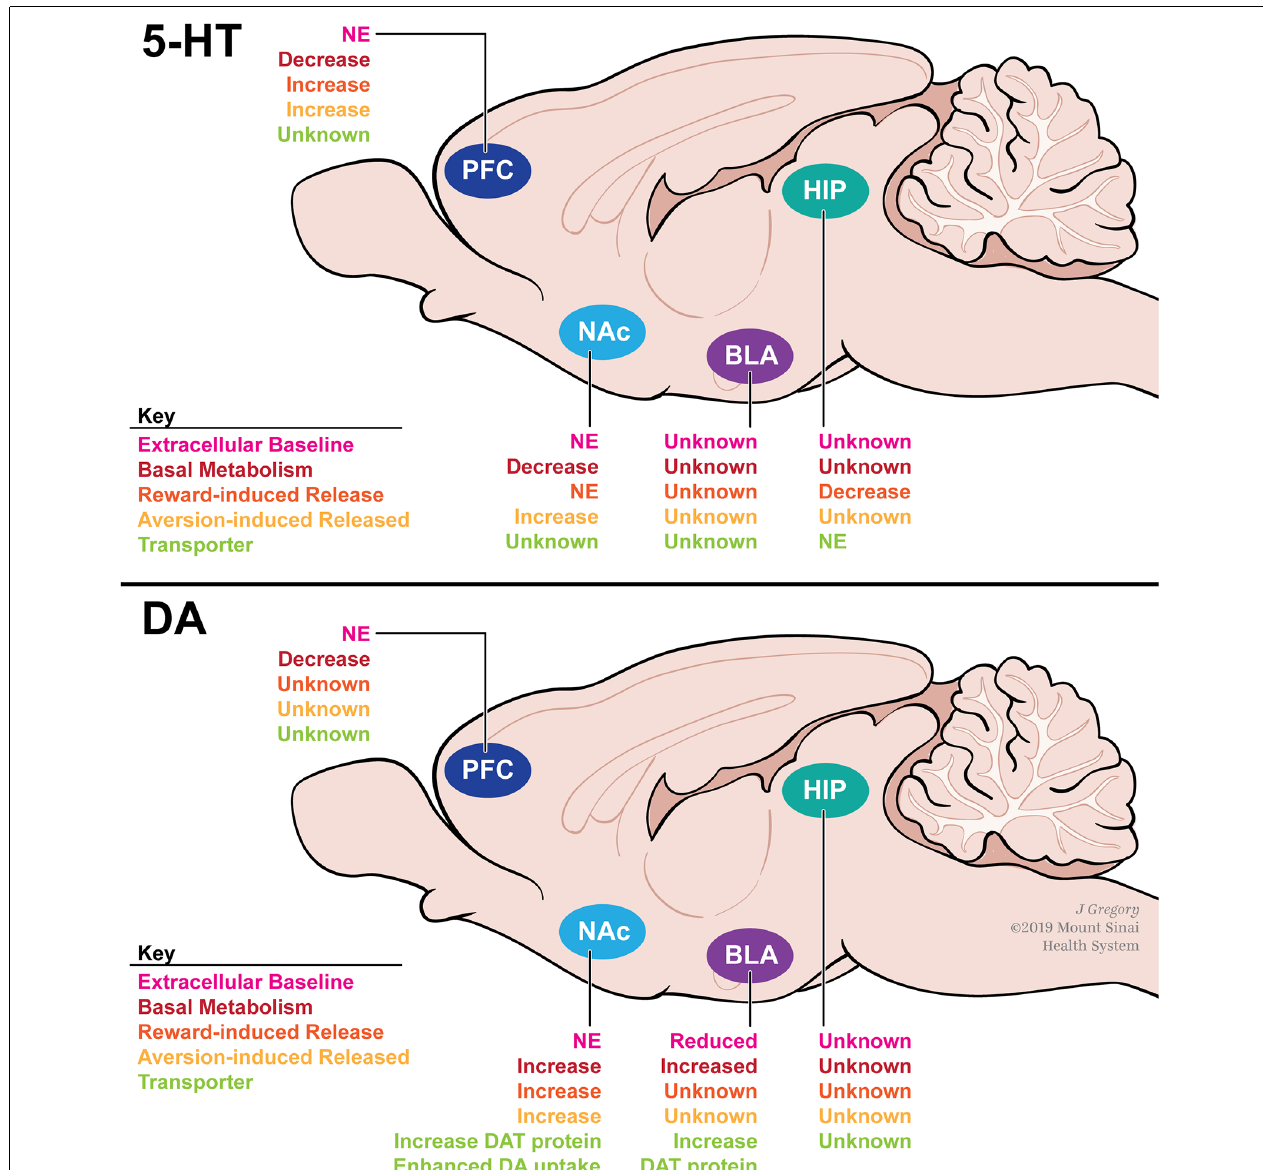
FIGURE 3 | A summary of how adolescent social isolation rearing alters serotonin (top) and DA (bottom) dynamics within the reward circuitry of rodents. Social isolation rearing has been shown to alter metabolism (red) and release (orange and yellow) of serotonin in the PFC, NAc and HIP in a region-specific manner. Similarly, social isolation rearing has been shown to alter baseline DA (pink) as well as metabolism (red), release (orange and yellow) and reuptake through actions on DAT (green) in a region-specific manner. Abbreviations: PFC, prefrontal cortex; NAc, nucleus accumbens; BLA, basolateral amygdala; HIP, hippocampus; NE, no effect; DAT, dopamine